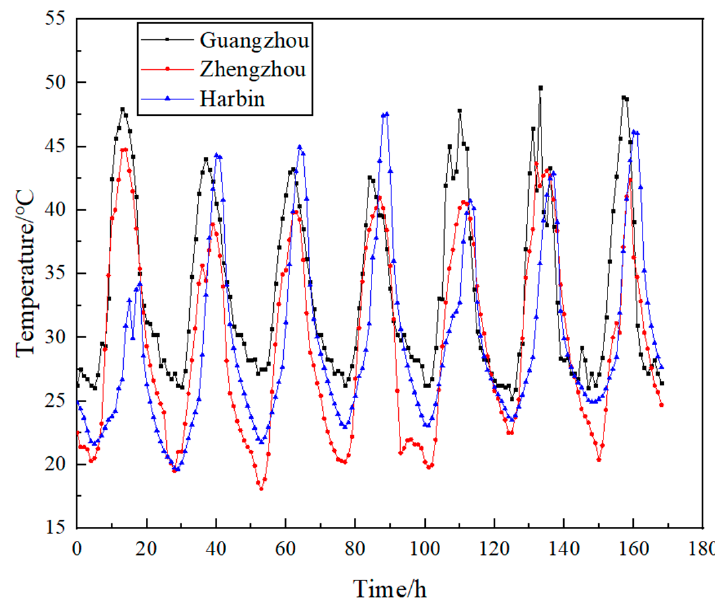
Figure 1. The temperature distribution in the three cities in July [40].